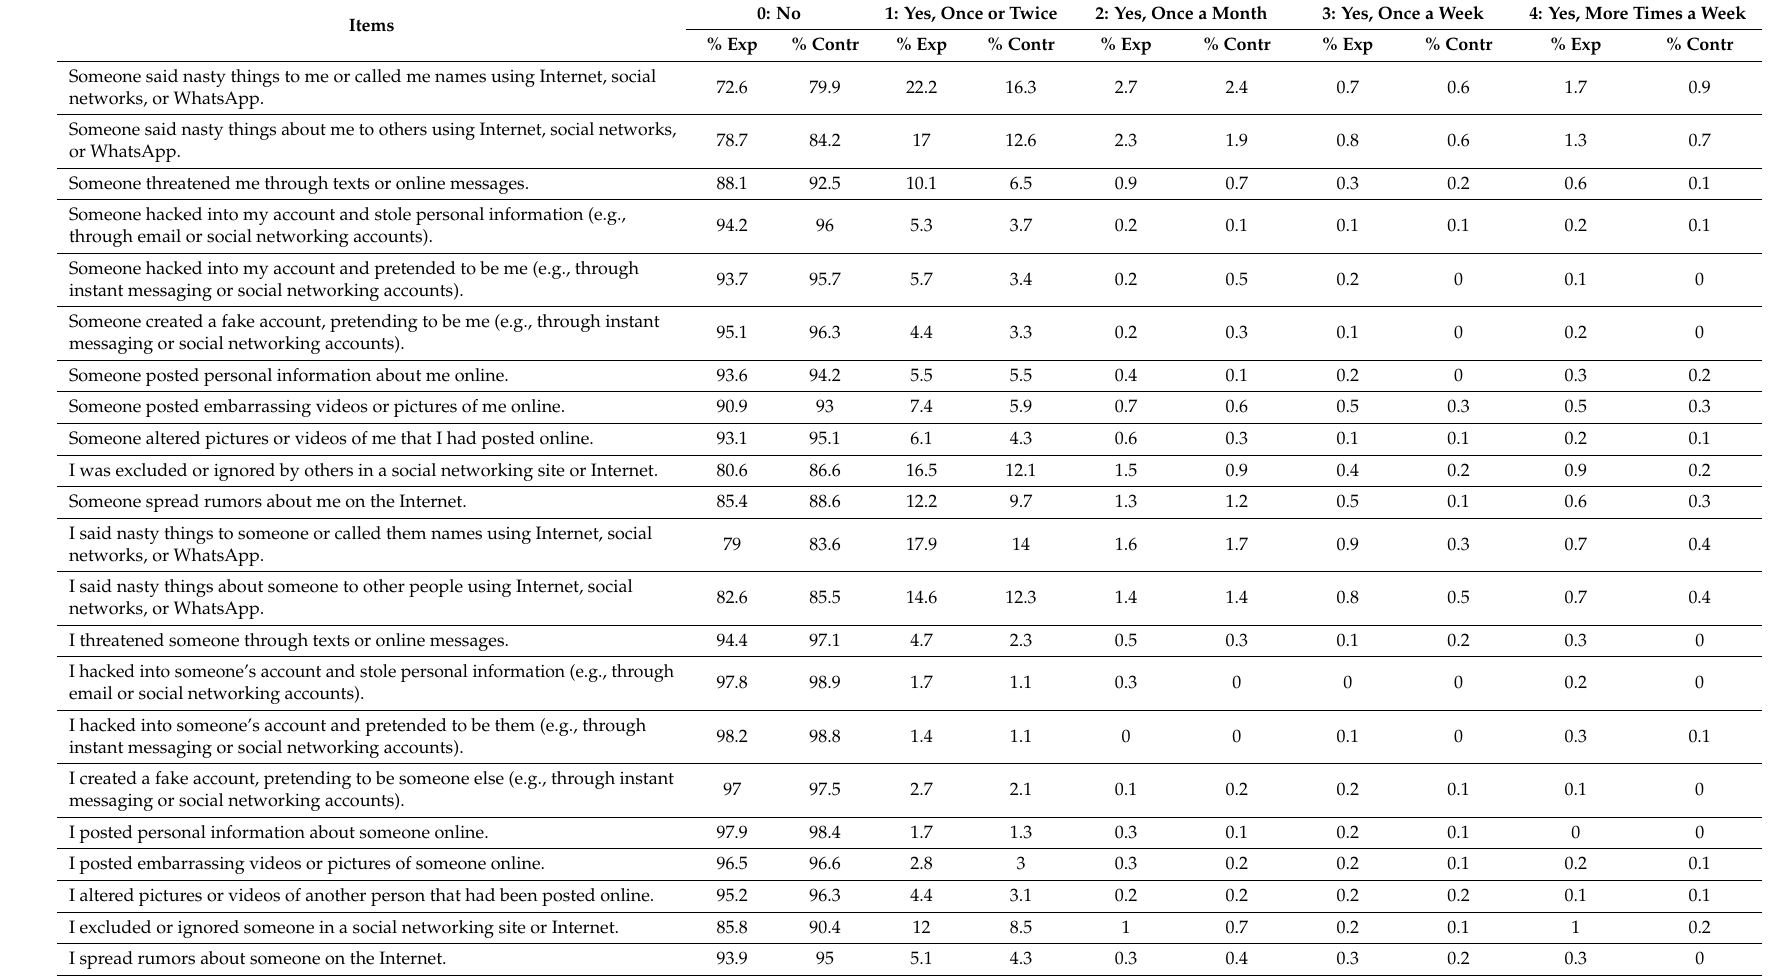
Table 1. Descriptive results calculated by groups experimental and